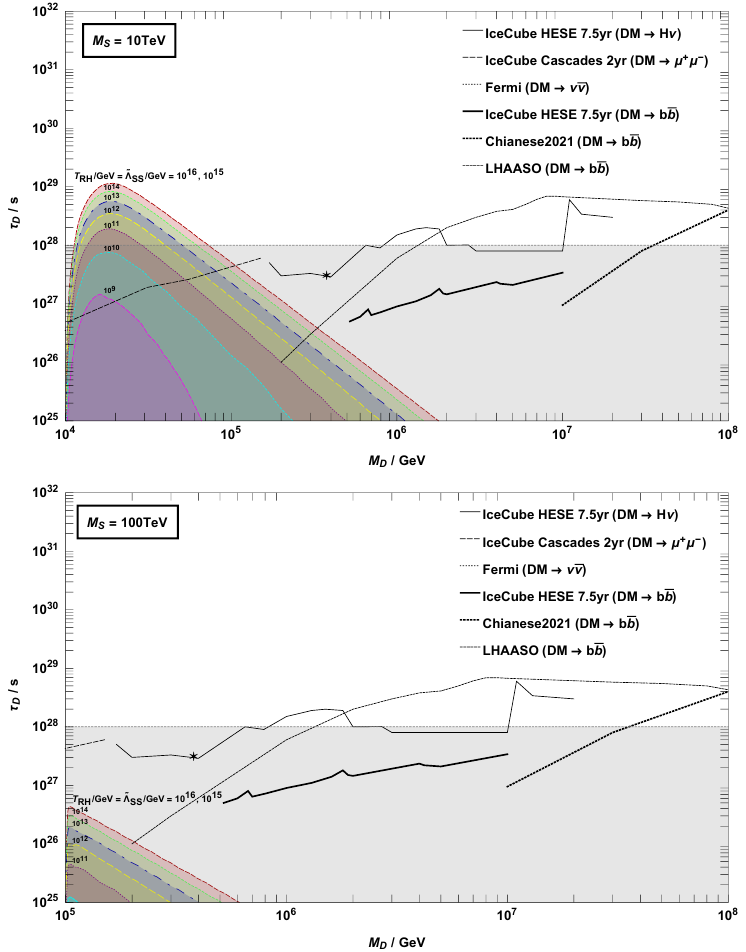
Figure 8 . As in figure 7 but for M S = 10 TeV (top) and M S = 100 TeV